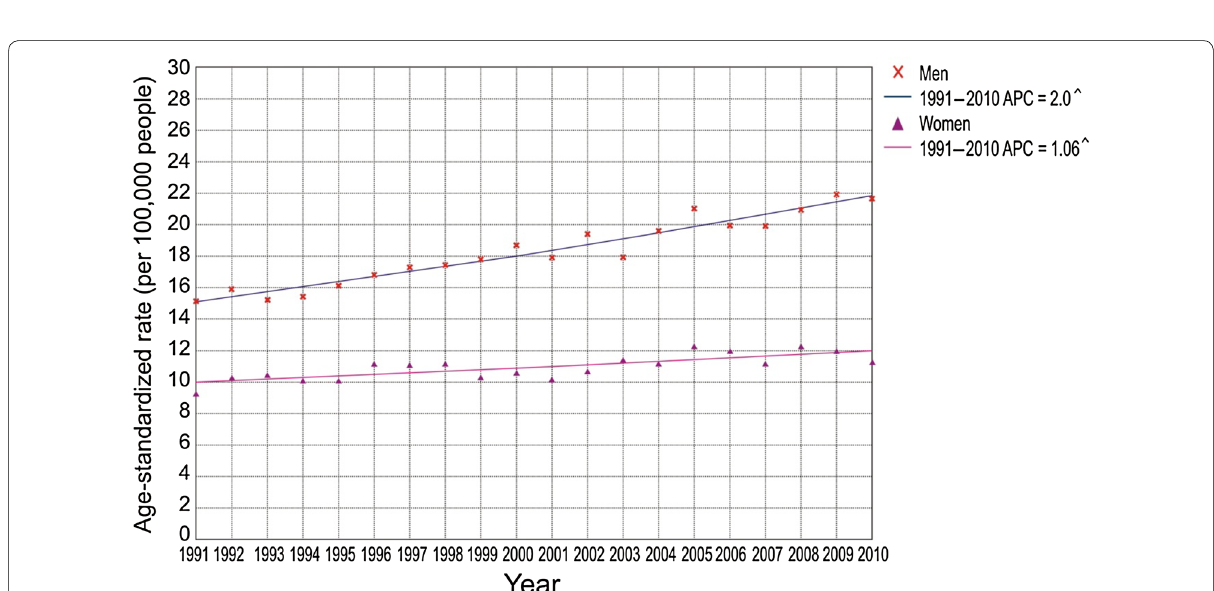
Fig. 2 Trend in mortality of colorectal cancer in Serbia, by sex, during the period 1991–2010: a joinpoint regression analysis. ^ Statistically